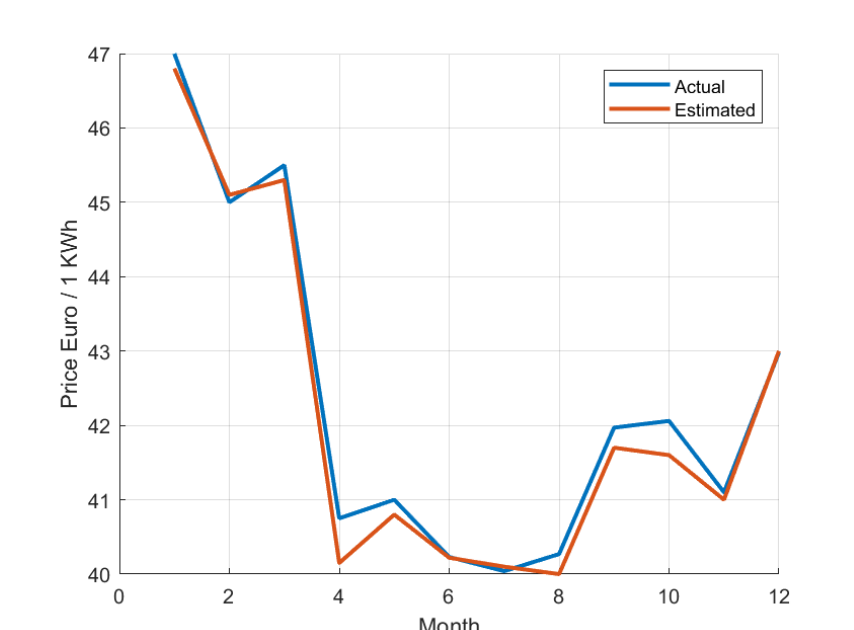
Figure 9. A comparison of estimated EP and the actual EP values in